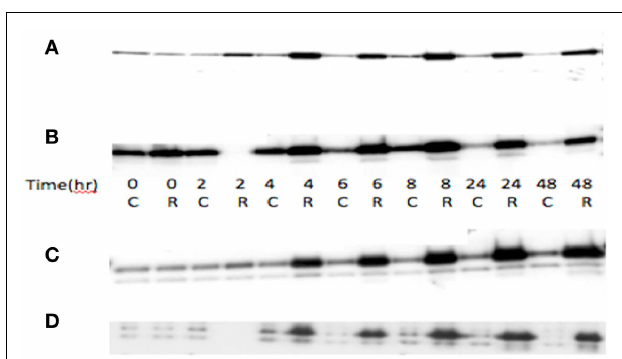
FIGURE 1 |TP53 and p21 protein expression in radiated (R) vs. control (C) inA2780 cell line . (A) Wild-type A2780 cell line shows increasedTP53 expression in radiated vs. control samples. (B) TP53 mutant A2780 cell line with induction ofTP53 expression in radiated vs. control samples.TP53 protein expression increase seen at 4h, with greatest increase at 6–8h, and induction sustained to 48h. (C) p21 protein expression in wild-type cells. Increased expression noted at 4h and sustained to 48h. (D) p21 expression in TP53 mutant cell line. Induction of expression noted at 4h, sustained to